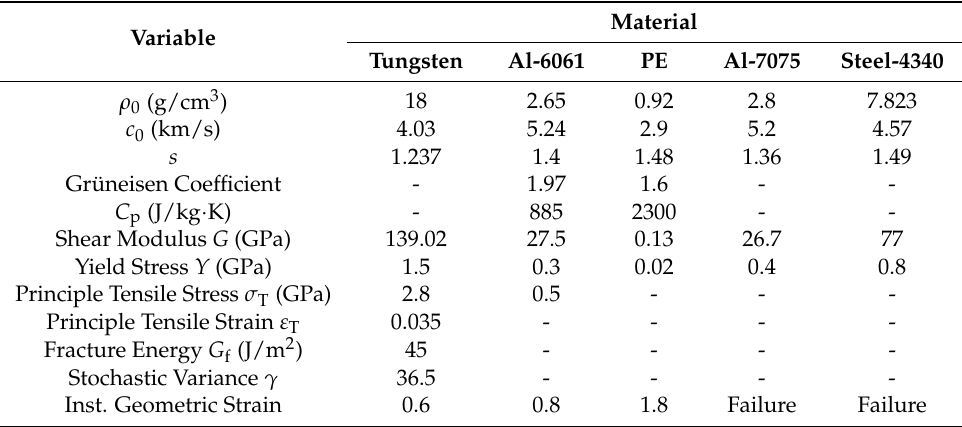
Table 1. Material parameters in the numerical